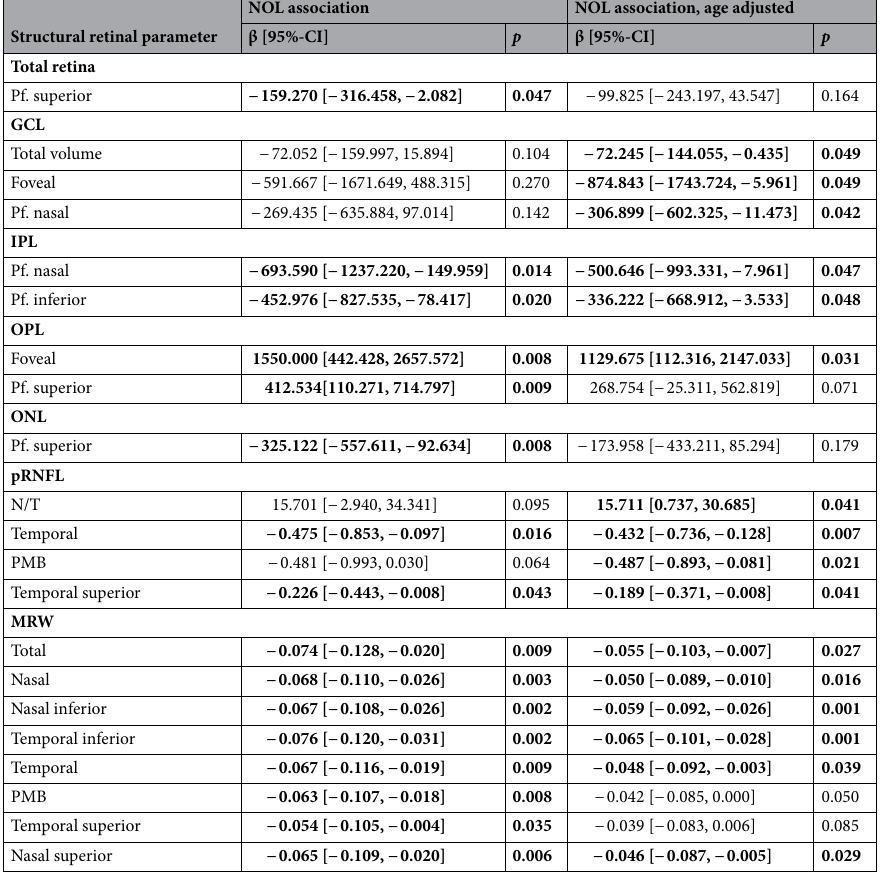
Table 2). After adjusting for age, GCL, IPL and OPL volumes as well as MRW and pRNFL thickness were signifi- cantly associated with NOL (Table 4 and Supplementary Table 2). In stepwise multivariate linear regression foveal